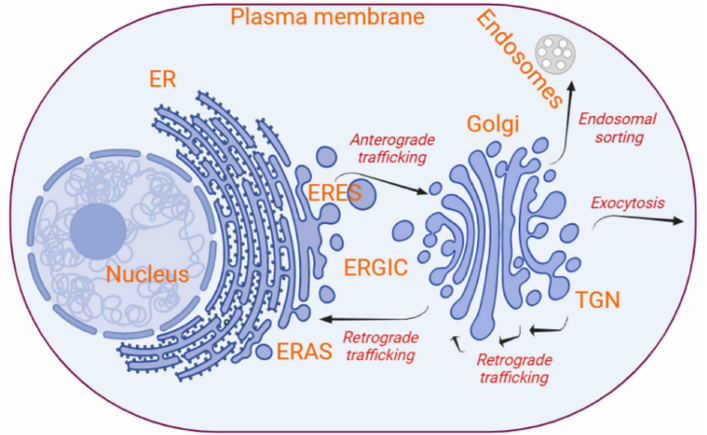
Figure 1. Overview of the secretory transport route and its key components. The compartments characterizing the conventional secretory route are the ER, the ERGIC, the Golgi apparatus (which is subdivided into cis-, medial and trans-Golgi and TGN) and the plasma membrane. Lipid bilayers and proteins are mainly trafficked between these compartments mostly by bidirectional vesicle transport. At a specialized subdomain of the ER, the ERES, cargoes are packed into COPII-coated vesicles